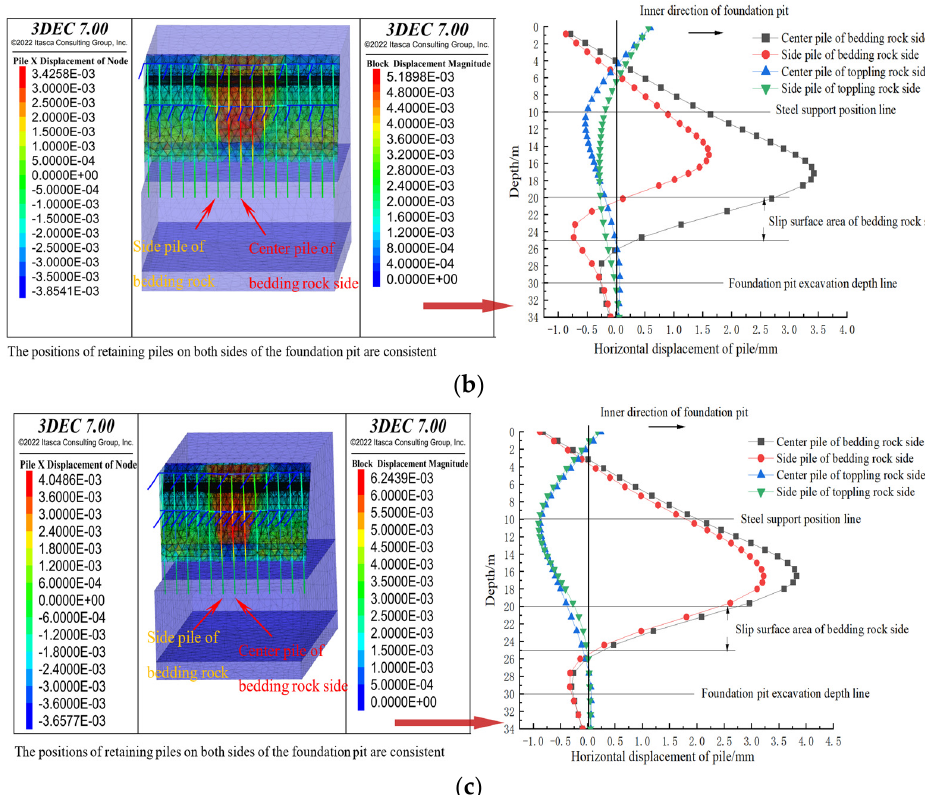
Figure 13. Analysis on the stress of pile-bracing support system. ( a ) displacement of retaining piles with a pile spacing of 2.0 times; ( b ) displacement of retaining piles with a pile spacing of 3.0 times; ( c ) displacement of retaining piles with a pile spacing of 4.0 times.